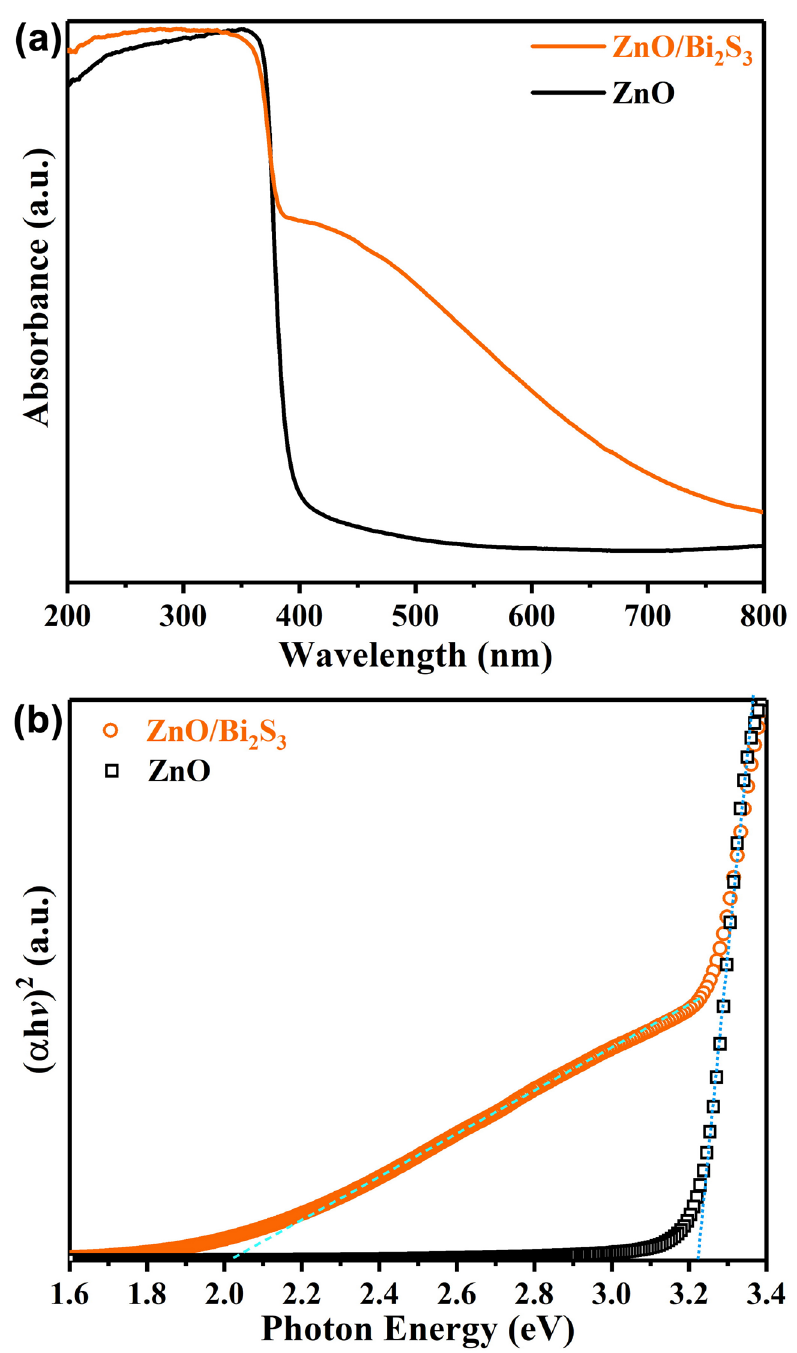
Figure 5. ( a ) UV–Vis absorption spectra and ( b ) Tauc plots of ZnO and ZnO/Bi 2 S 3 photoanodes.